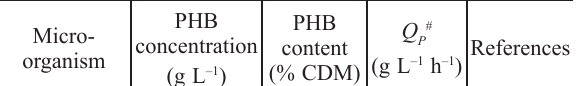
Table 3 – Comparison of present repeated batch strategy with literature reports for PHB production using Azohydromonas australica or similar strains PHB Micro- organism